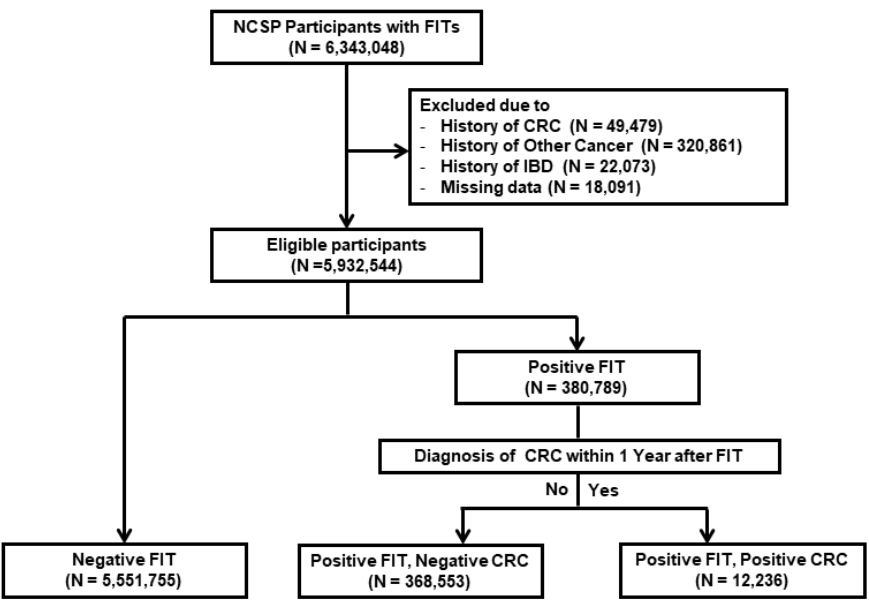
Figure 1. Flow chart of study participants. FIT, fecal immunochemical test; CRC, colorectal cancer; IBD, inflammatory bowel disease.